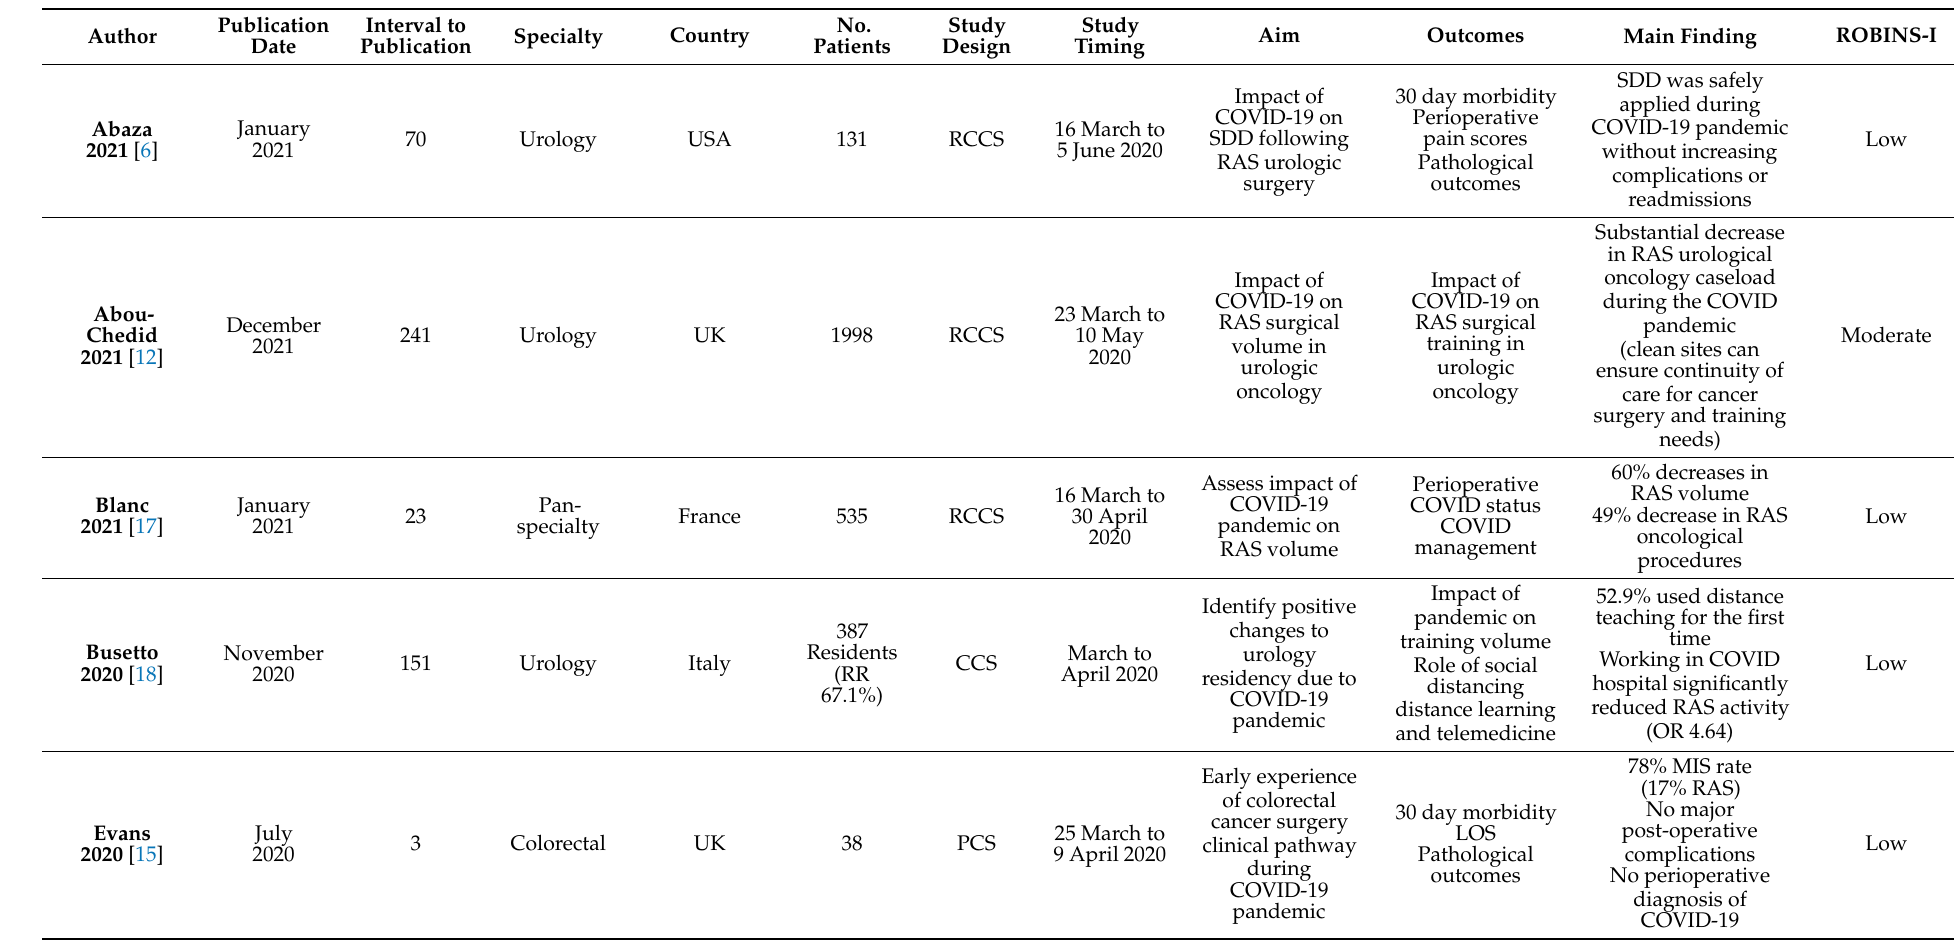
Table 1. Study and publication characteristics of studies reporting on robotic surgery during the SARS-CoV-2